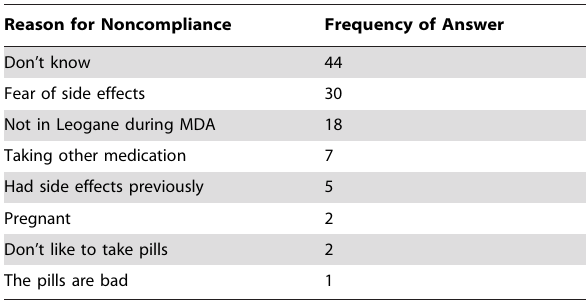
Table 6. Nearest neighbor analysis for spatial